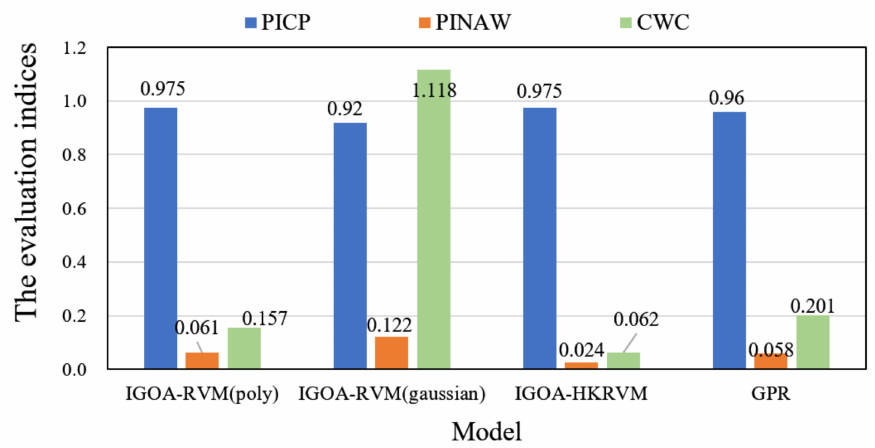
Figure 8. The comparison of di ff erent interval prediction models.